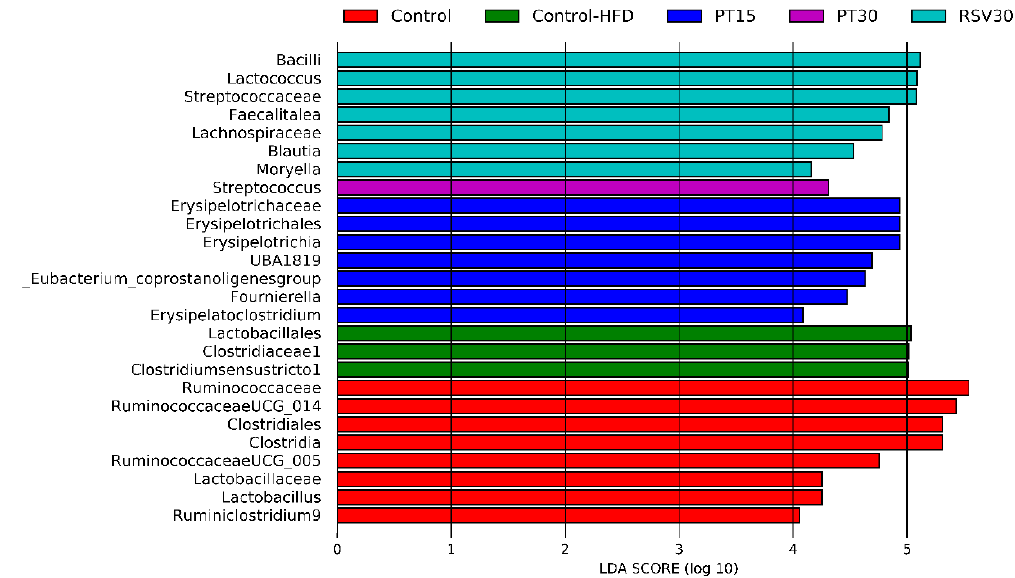
Figure 6. Linear discriminant analysis (LDA) integrated with effect size (LEfSe). Differentially abundant taxonomic groups the microbiota of rats after treatment with pterostilbene and resveratrol (α = 0.05, LDA score > 4).